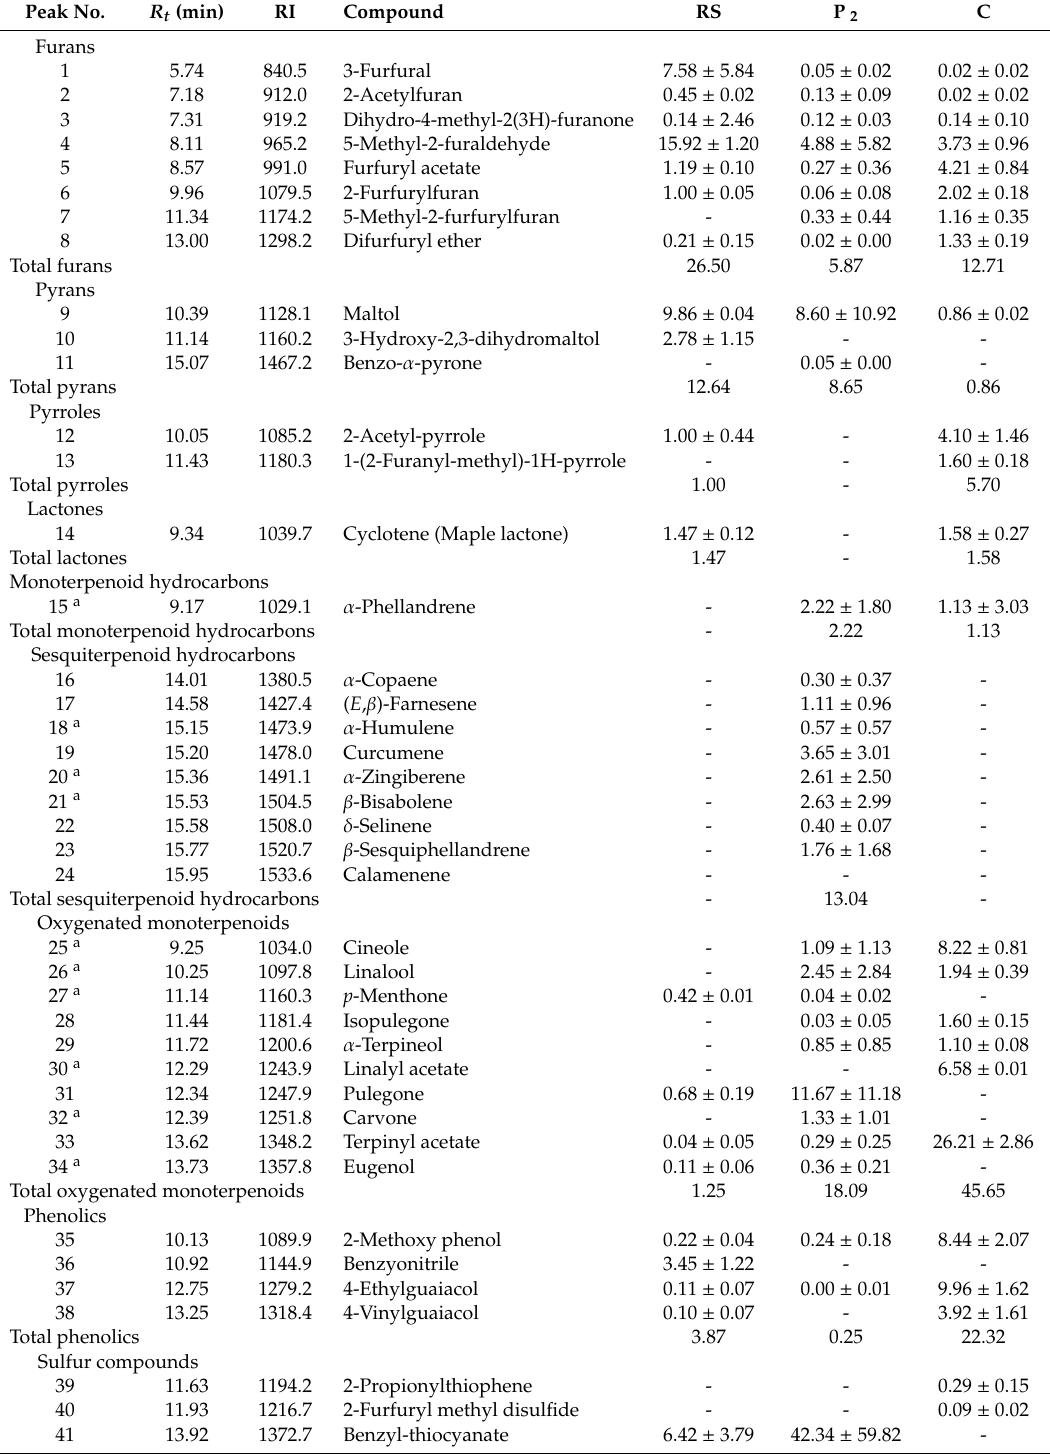
Table 1. Relative percentage of volatile components in roasted pits (RS), pit product two (P 2 ) and co ff ee product (C) using headspace SPME-GCMS. Each value represents mean ± S.D. ( n = 3). Peak